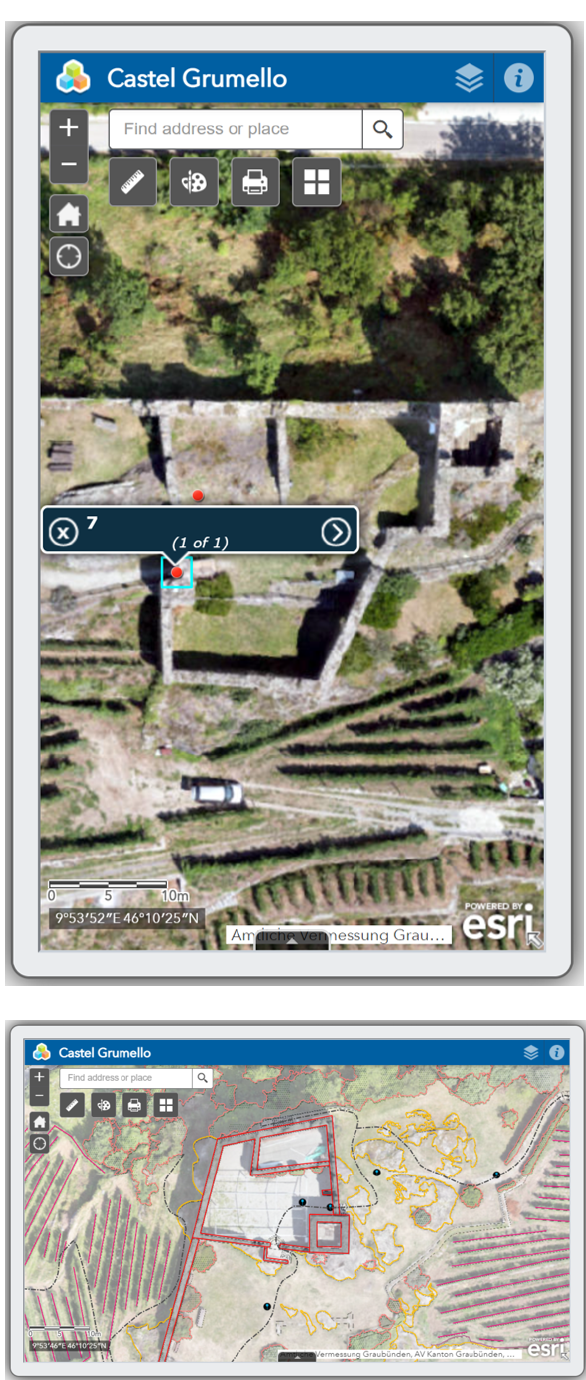
Figure 10: The developed web-GIS app (top) with icons to access the different layers of the rendered equirectangular